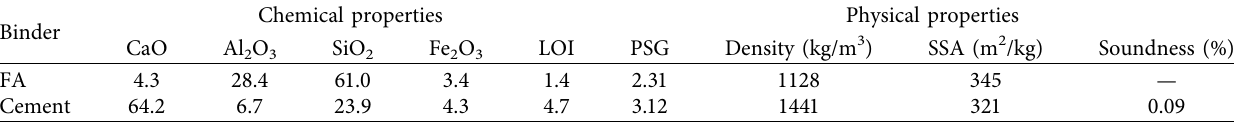
Table 1: Engineering characteristics of binders used in this study.